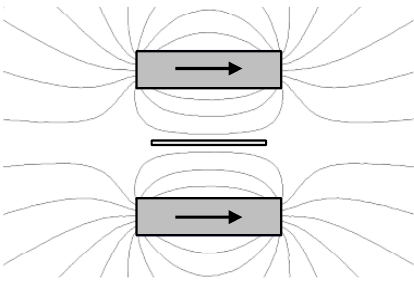
Figure 9. Biasing magnet arrangement and resulting field lines. Transducer is shown in between the two magnets. two